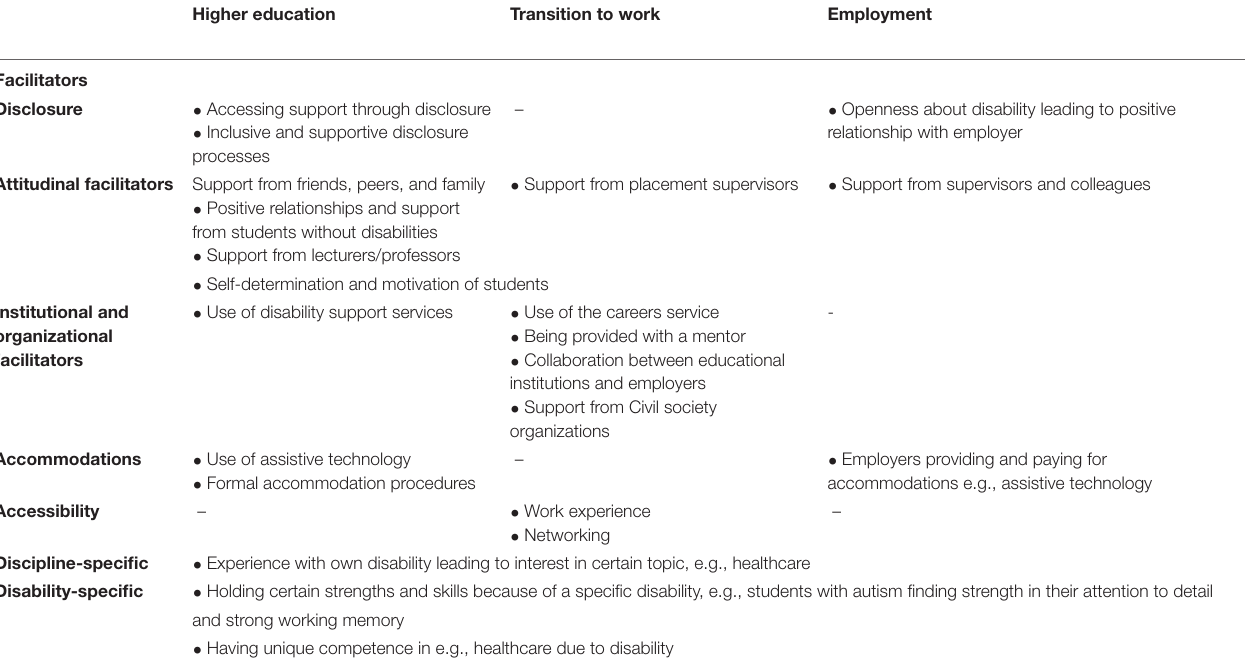
TABLE 3 | Facilitators in the transition from higher education to employment. Higher education Transition to work